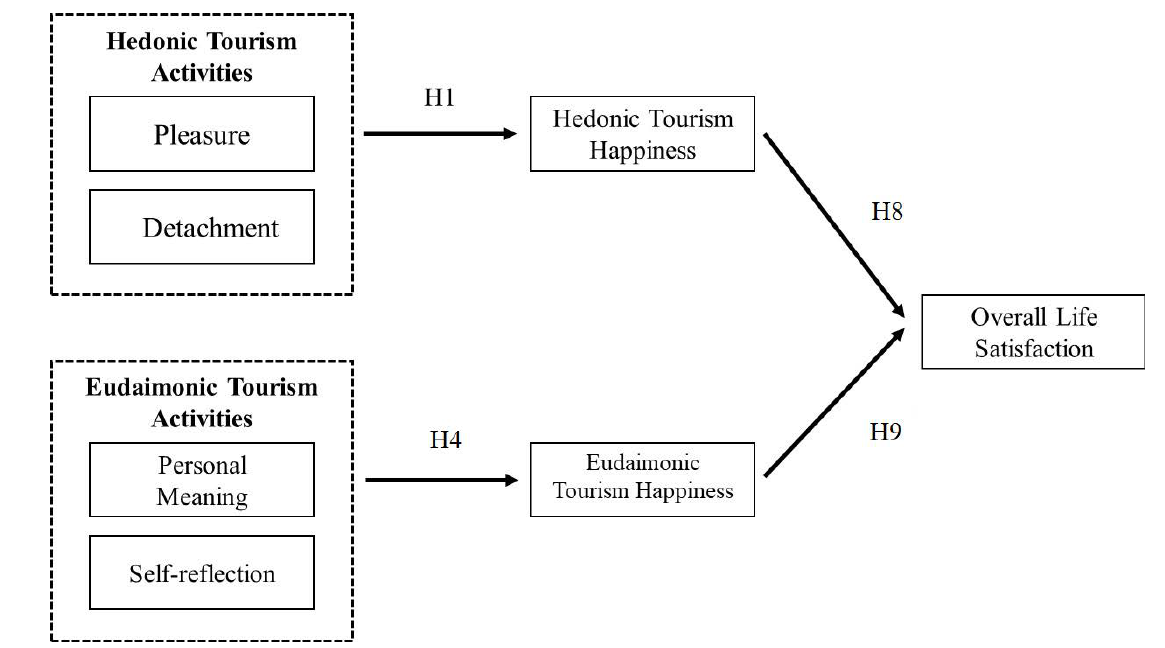
Figure 2. Research Model.